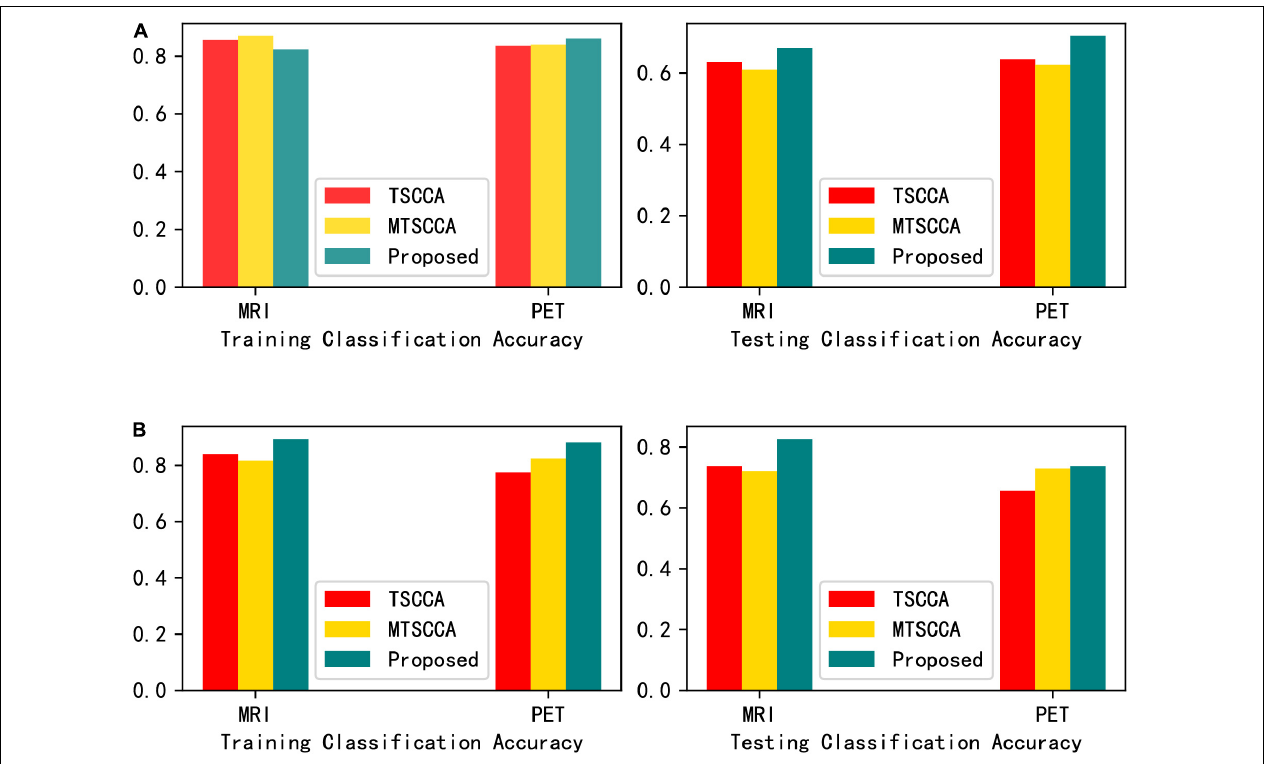
FIGURE 6 | (A) Comparison of the classification accuracy of the selected imaging QTs by support vector machine (SVM). (B) Comparison of the classification accuracy of the selected imaging QTs by random forest (RF).